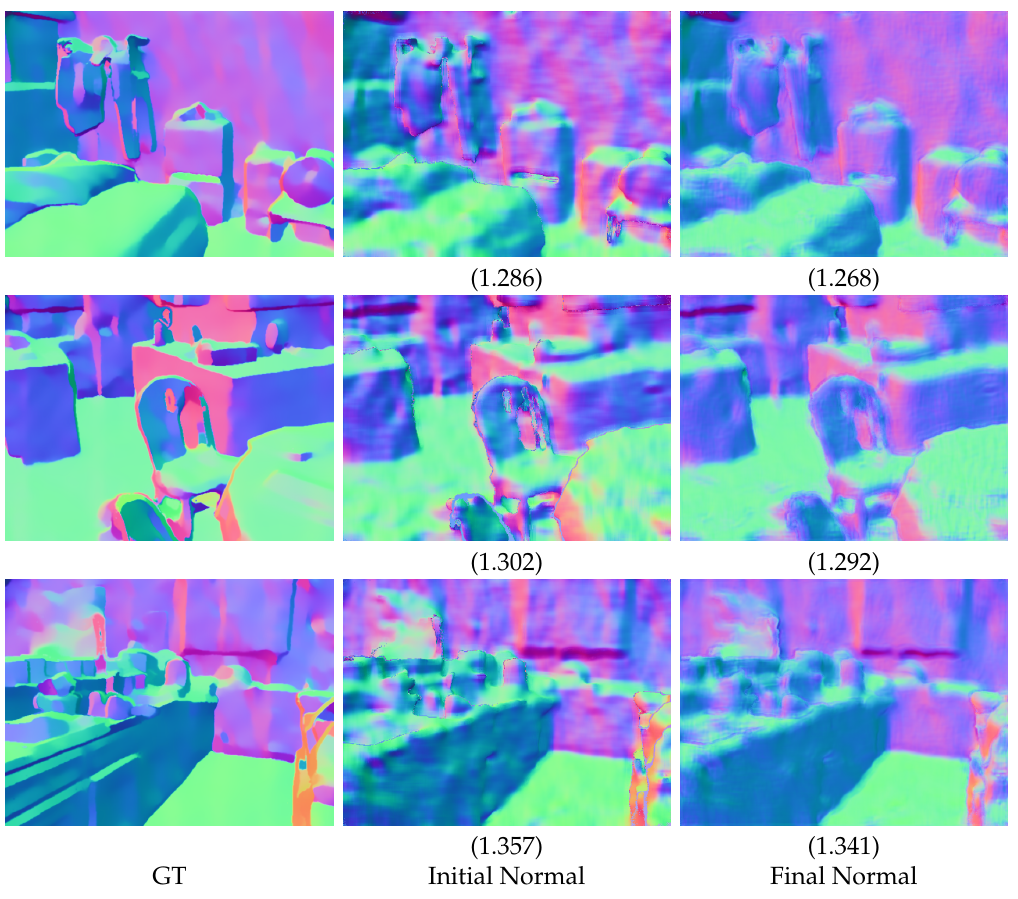
Figure 6. Visualization of normal map quality on three scenes of the NYU v2 dataset using the ADNet backbone. Values directly under the image are mean angular error to ground